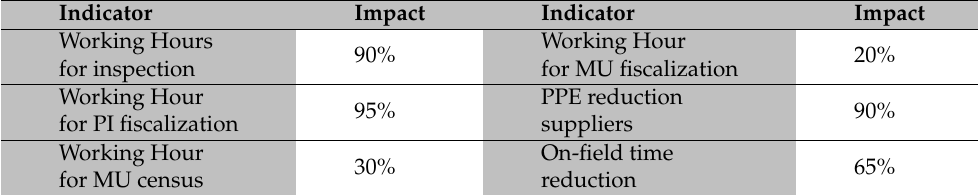
Table 1. Product impact in on-field